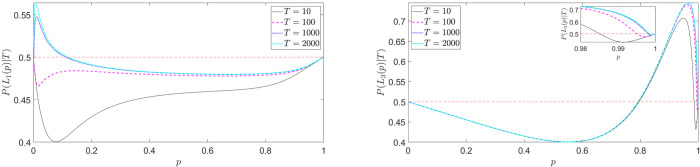
Fourfold pattern of risk attitudes: Time-constrained choice probabilities for different values of T (Eq (19)).(a) P(L1(p)|T) for task (A); (b) P(L3(p)|T) for task (B) (the inset shows the choice probabilities for high-values of p). In this example we set r = 4, D = 10.